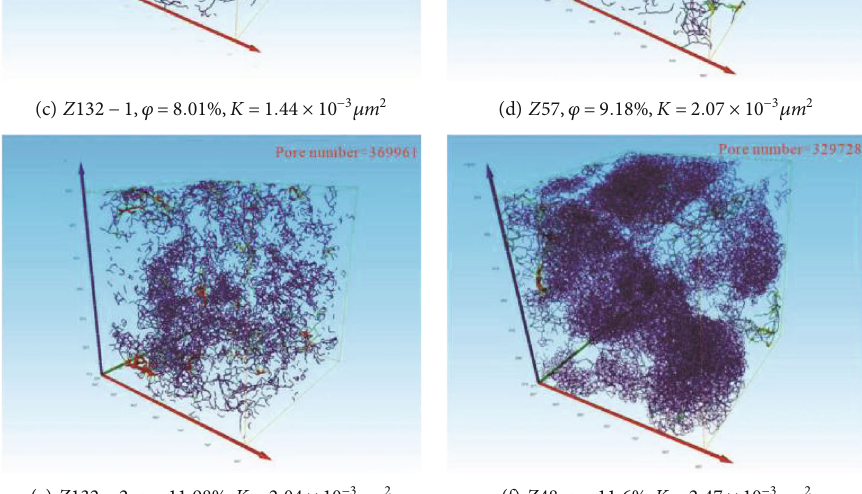
Figure 4: Microscale pore model of tight oil reservoir in the study